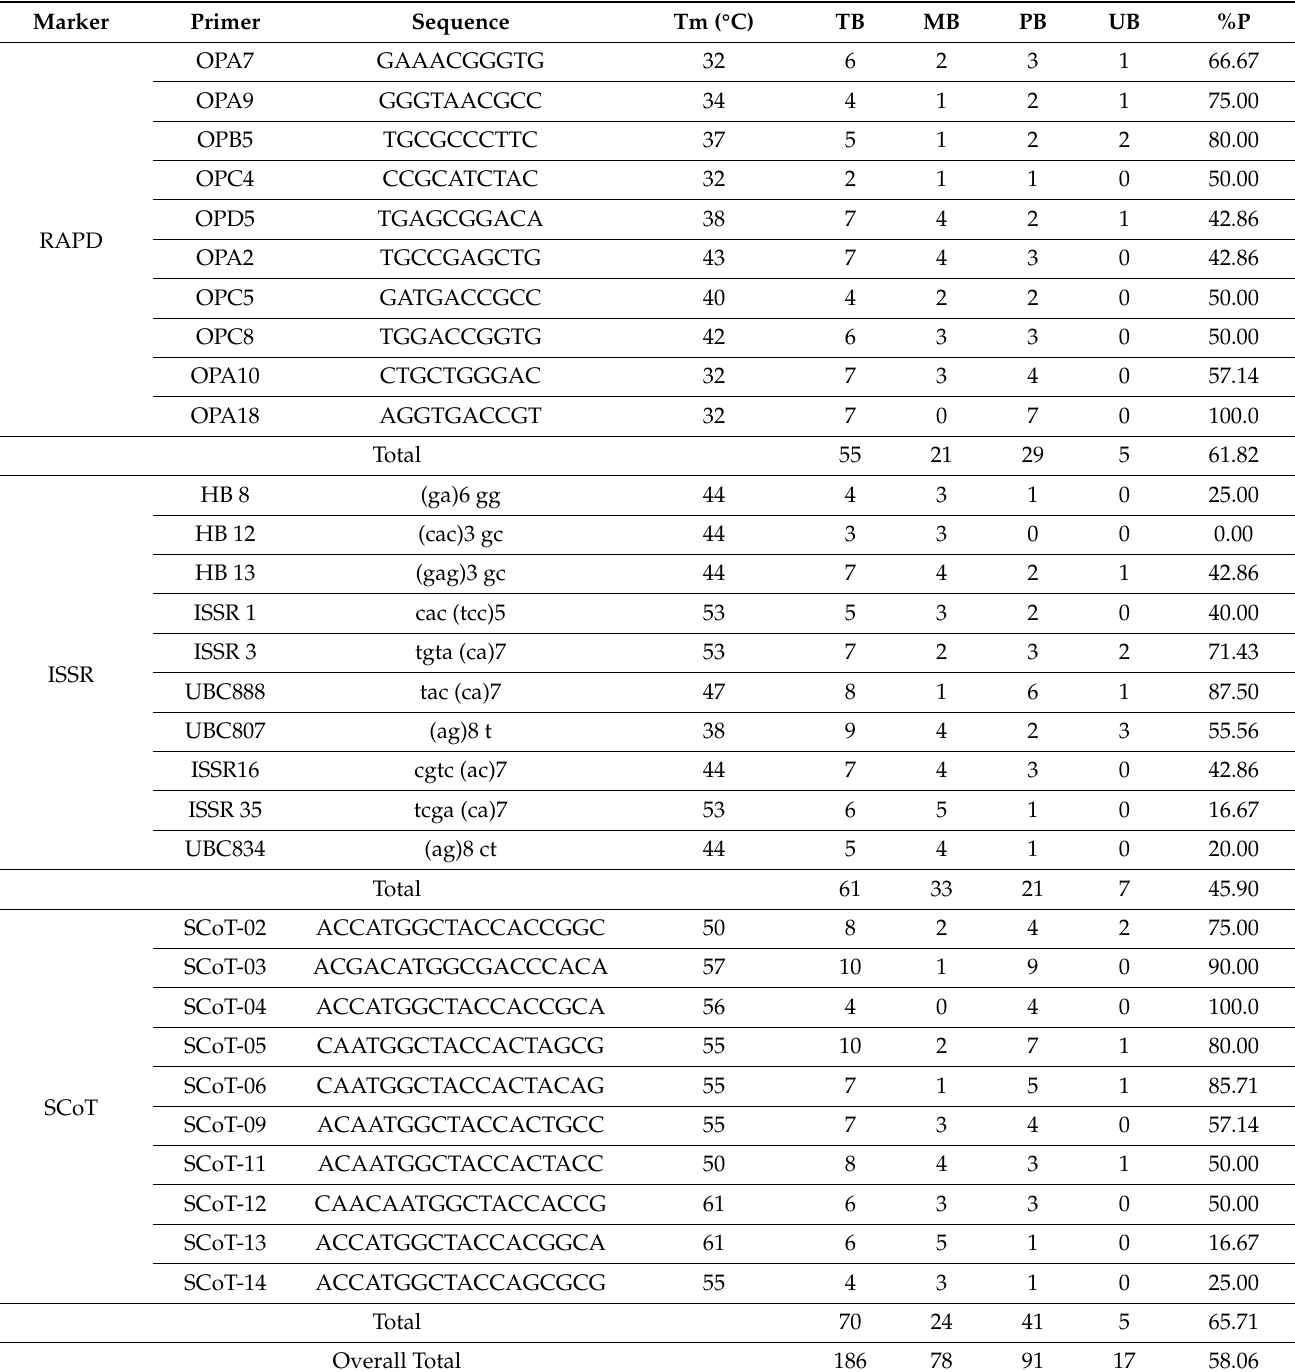
Table 3. Primer names, sequences (5’-3’), and their annealing temperatures (T a ), total, monomorphic, polymorphic, and unique bands, and polymorphism (%) for the three markers used in the